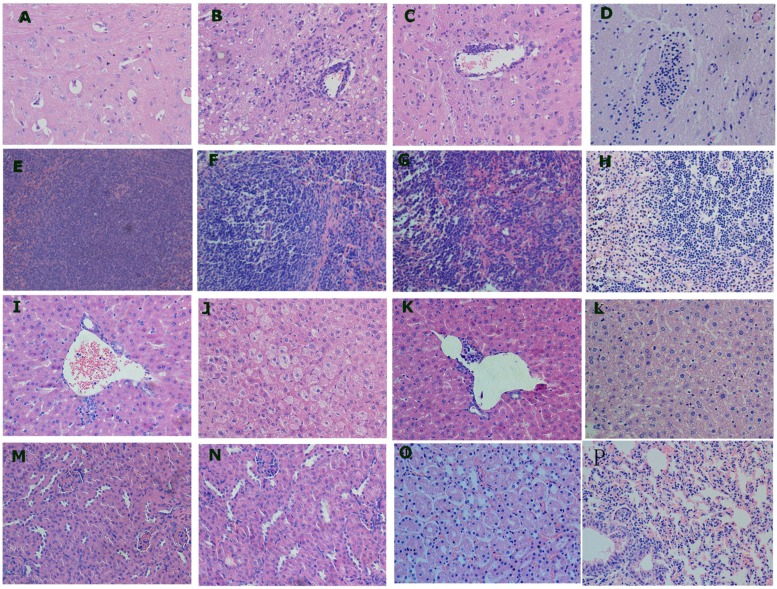
Microscopic pathological changes of 3-week-old mice inoculated with TMUV by i.c.
(A) Brain, 4 dpi: microglia cell proliferation and capillary edema; (B,C) Brain, 8 and 12 dpi: severe lymphoid perivascular cuffing, perivascular lymphoid infiltration and fatty degeneration of nerve cells; (D) Brain, dead mice: severe microglial nodules and perivascular cuffing formation; (E) Spleen, 4 dpi: endothelial swelling; (F,G) Spleen, 8 and 12 dpi: varying degrees of lymphoid cell depletion; (H) Spleen, dead mice: severe lymphoid cell depletion; (I,K) Liver, 4 and 12 dpi: perivascular inflammatory cells infiltration; (J) Liver, 8 dpi: moderate necrosis of hepatocytes; (L) Liver, dead mice: multifocal necrosis of hepatocytes; (M,N) Kidney, 8 and 12 dpi: narrowing tubular lumen and epithelial cell shedding; (O) Kidney, dead mice: severe and extensive tubular epithelial cell shedding; (P) Lung, 8 dpi: interstitial pneumonia with inflammatory cells infiltration and capillary congestion of alveoli.